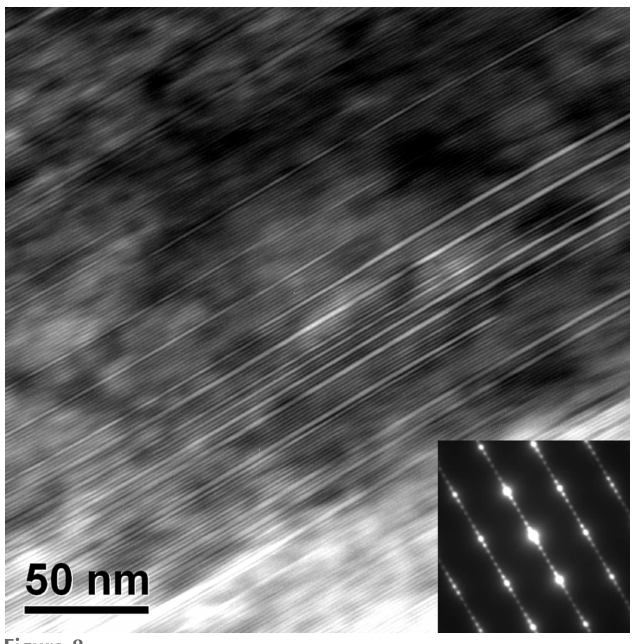
Figure 8 A TEM bright-field image along h 2 1 0 i 7M , showing the internal substructure of the 7M martensite plate. The inset shows the corresponding SAED